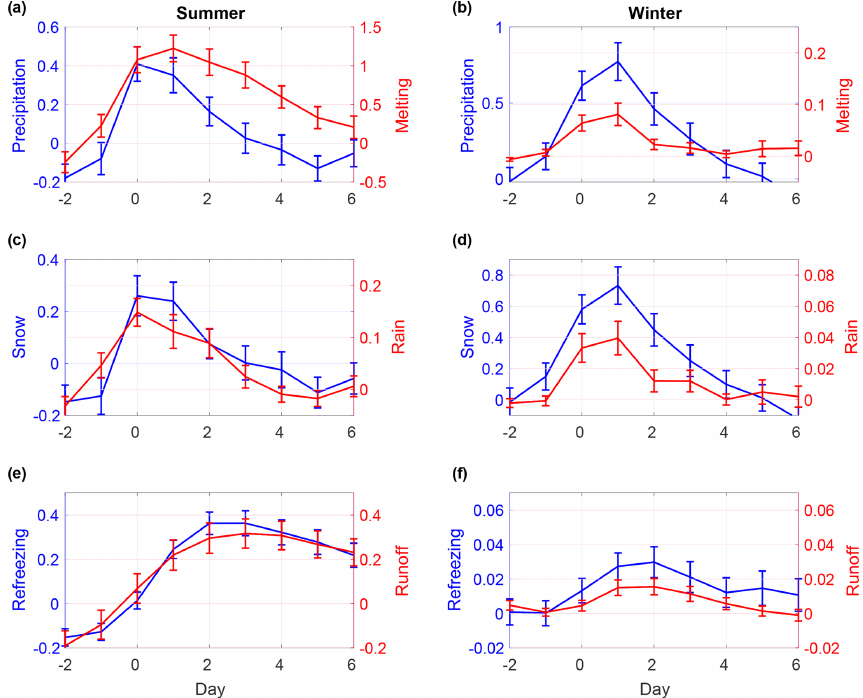
Figure 10. Composite evolution of (a, b) surface melt and precipitation, (c, d) rainfall and snowfall and (e, f) runoff and refreezing during melt events in summer and winter, all in millimeters of water equivalents, averaged over the ice sheet, obtained from MAR. Shown are the anomalies (in millimeters of water equivalents per day) with respect to the mean of the current month, based on the period 1988–2012.